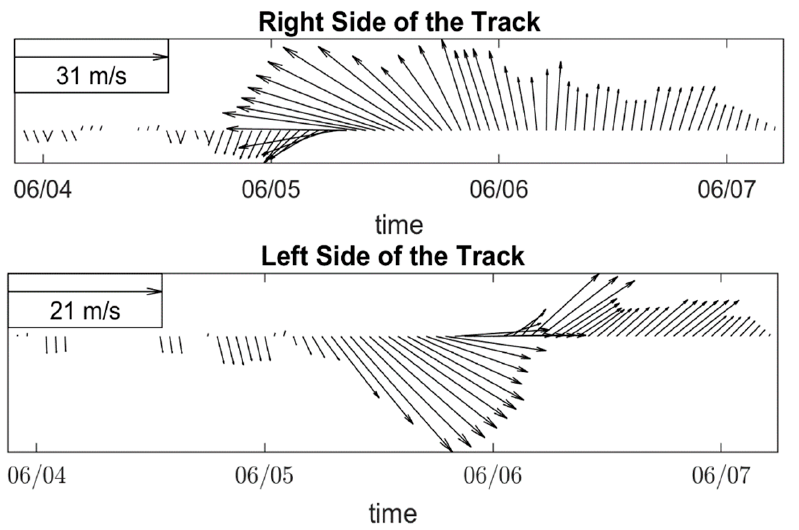
Figure 4. Time variations of Gonu’s wind vector from 4–7 June at locations on the right and left sides of the track (points 3 and 4 in Figure 1b).